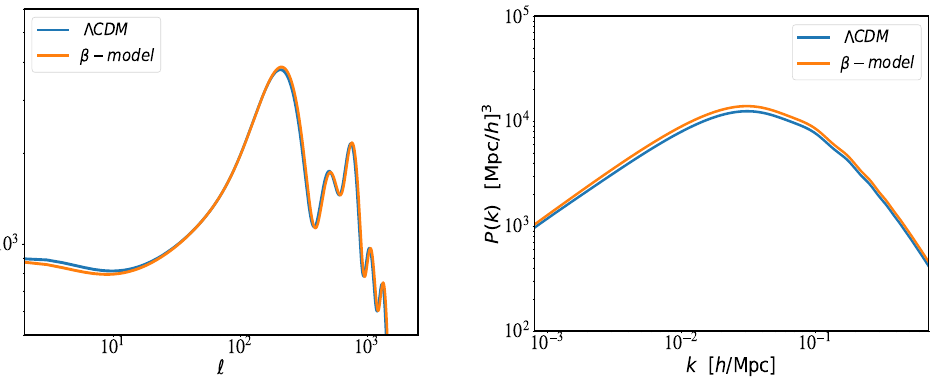
Figure 4. The left panel shows the unlensed CMB TT power spectrum for the flat Λ CDM (blue line) as compared with the β -model (orange line). In the right panel, the matter power spectrum P k is presented. (For interpretation of the references to color in this figure legend, the reader is referred to the web version of this